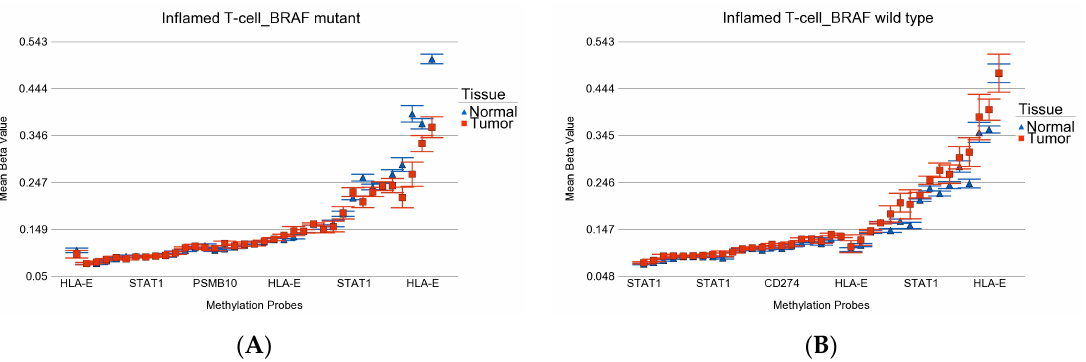
Figure 11. Differential methylation status of inflamed T-cell genes. Differential methylation in BRAF mutant patients is shown in ( A ), and the differential methylation of BRAF wild-type patients is shown in ( B ). Gene probes are arranged on the x -axis by methylation level, and the mean of beta value is shown on the y -axis. For many genes, there were multiple probes on the chip. Gene symbols for all gene probes could not be shown on the x -axis. Note that multiple probes were hypomethylated in BRAF mutant tumor and hypermethylated in BRAF wild-type tumor (interaction p = 3.67 × 10 − 13 ).